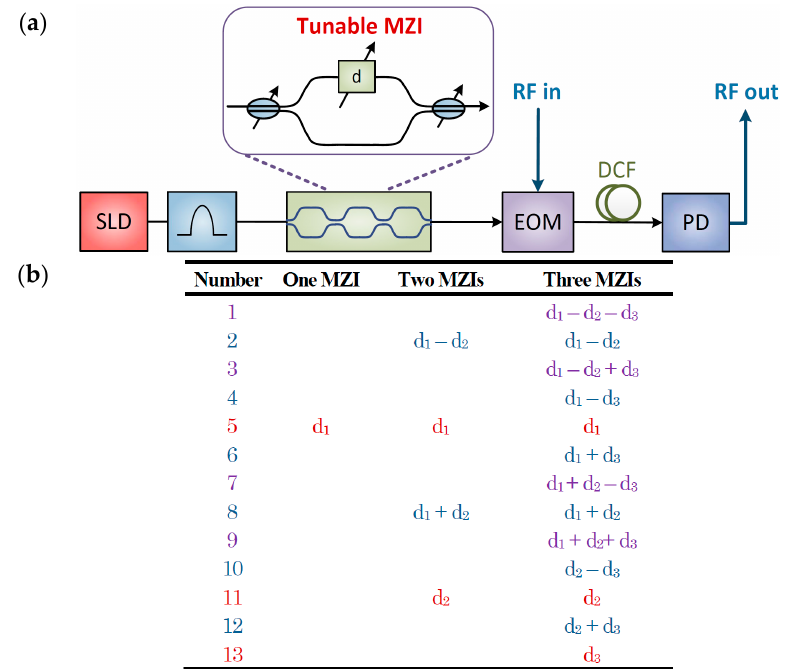
Figure 10. ( a ) Experimental setup of the cascaded tunable multiband microwave photonic filter [36]. SLD: Superluminescent diode; MZI: Mach-Zehnder interferometer; EOM: electro-optic modulator; DCF: dispersion compensating fiber; PD: photodetector. ( b ) 13 possible combinations of the cascaded MZI based microwave photonic multiband filter.